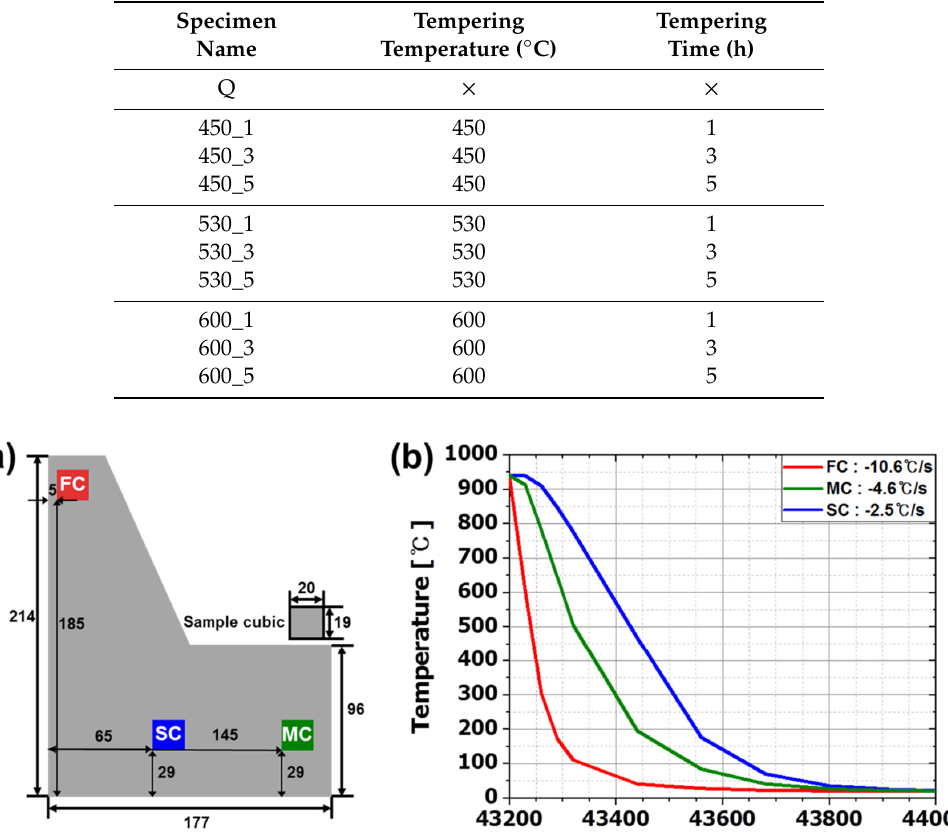
Table 2. Post-heat treatment conditions and symbols.